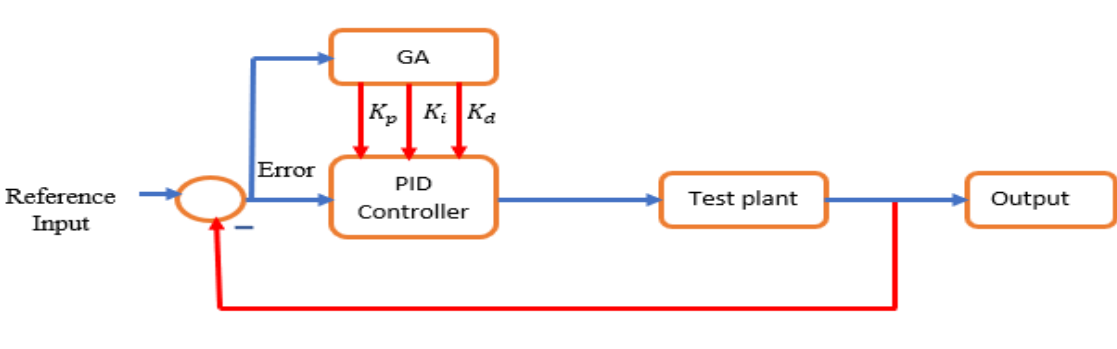
Fig. 4. Control the plant using a genetic